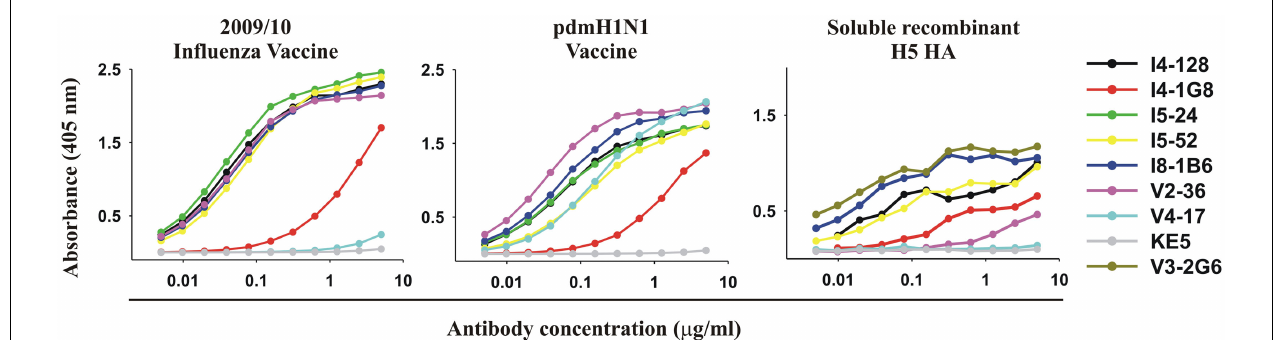
recombinant ectodomain of the HA of an H5N1 avian influenza virus A/Vietnam 1203/2004 (Clade 1) of 5 anti-HA stem mAbs (V3-2G6, I4-128,